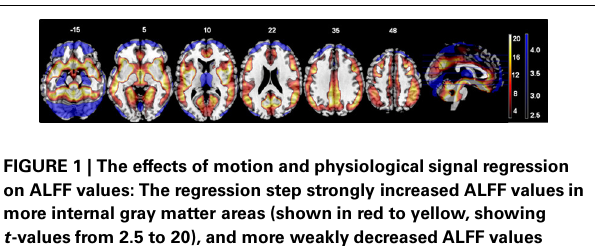
FIGURE 2 | The main effect of site in the original ALFF images, at the loci of maximal effect sizes (thresholded at F > 5; the color bar indicates the F -values). (A) Left: F-map overlaid on canonical brain (MNI coordinates 42, 36, − 6); Right: The effects for each site. Site 7, a 3T Siemens scanner, was the implicit baseline; the x-axis is the 6 other sites, with the GE site first. (B) Same but at MNI coordinates − 9, 24, 27.